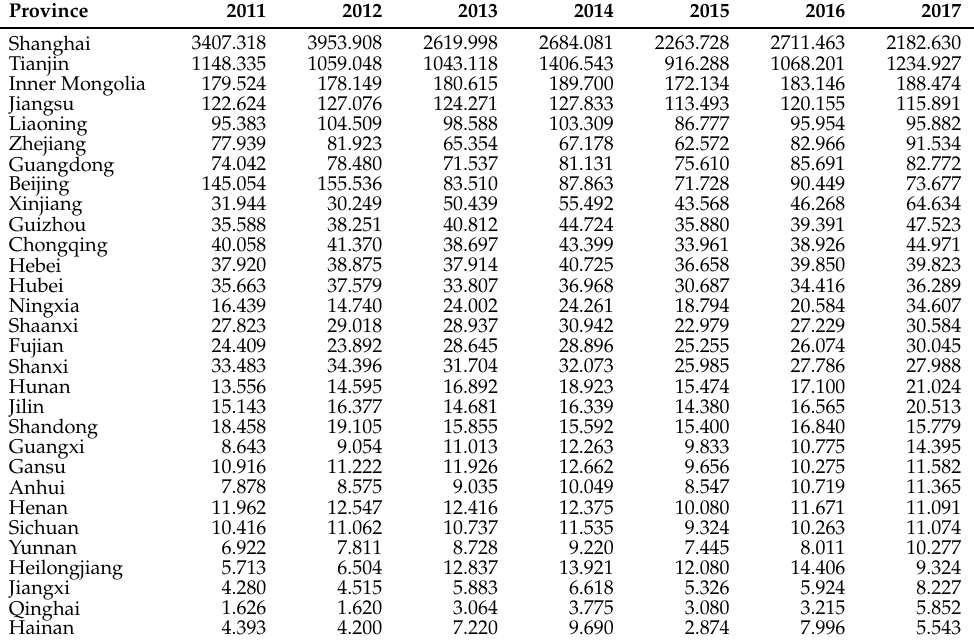
Table 6. The intra-provincial carbon inequality estimation results of original carbon emission data for 30 provinces in China from 2011 to 2017. The results are presented in descending order of carbon inequality in the latest year (2017). Due to space limitations, the results from 1997 to 2010 are in the Appendix